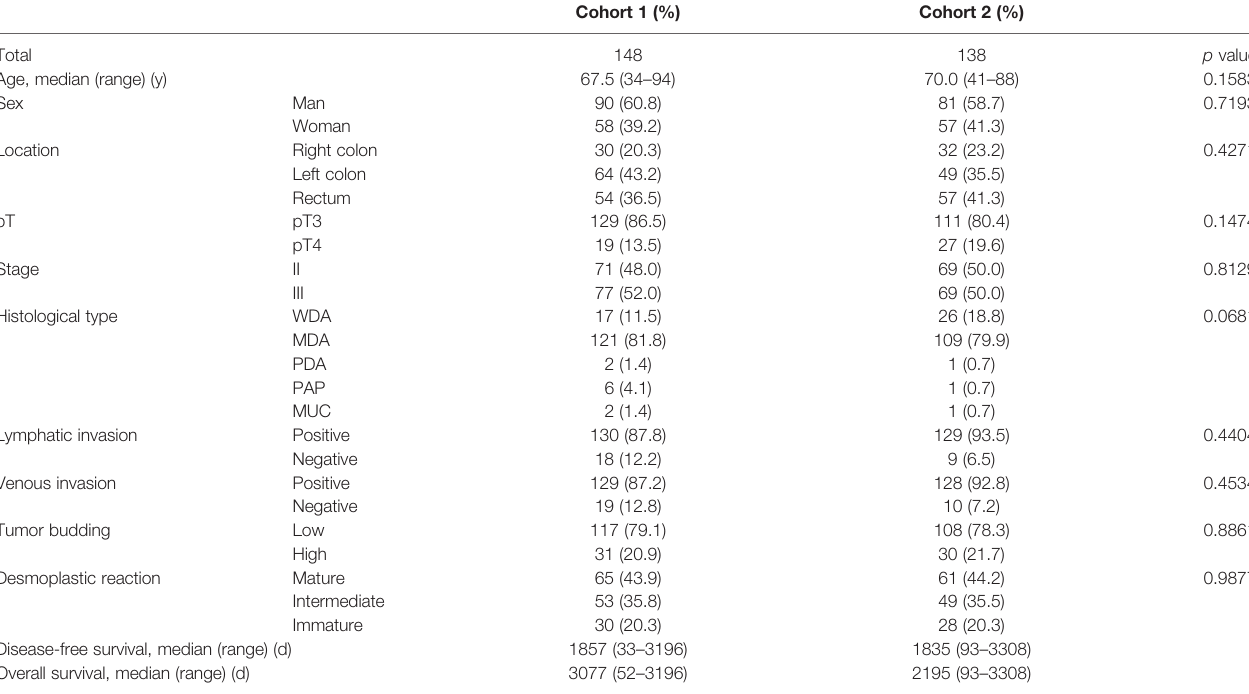
TABLE 1 | Clinicopathological fi ndings in stage II and III colorectal